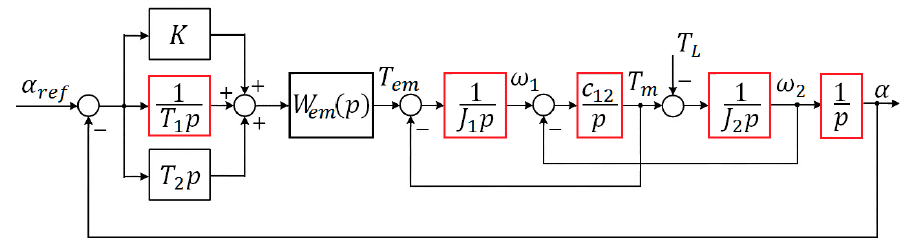
Figure 1. Structural diagram of electromechanical ACS, where T L is a load torque, T em is an elec- tromagnetic torque, T m is a mechanical torque, W em is a transfer function of link of electromagnetic torque formation, T 1 and T 2 are time constants of integral and differential channels of the regulator, K is a regulator proportional gain; J 1 is a motor inertia moment; J 2 is an inertia moment of mechanism; ω 1 is a motor speed; ω 2 is a mechanism speed; c 12 is a mechanism elasticity coefficient; α ref is a reference angle; and α is a displacement angle.